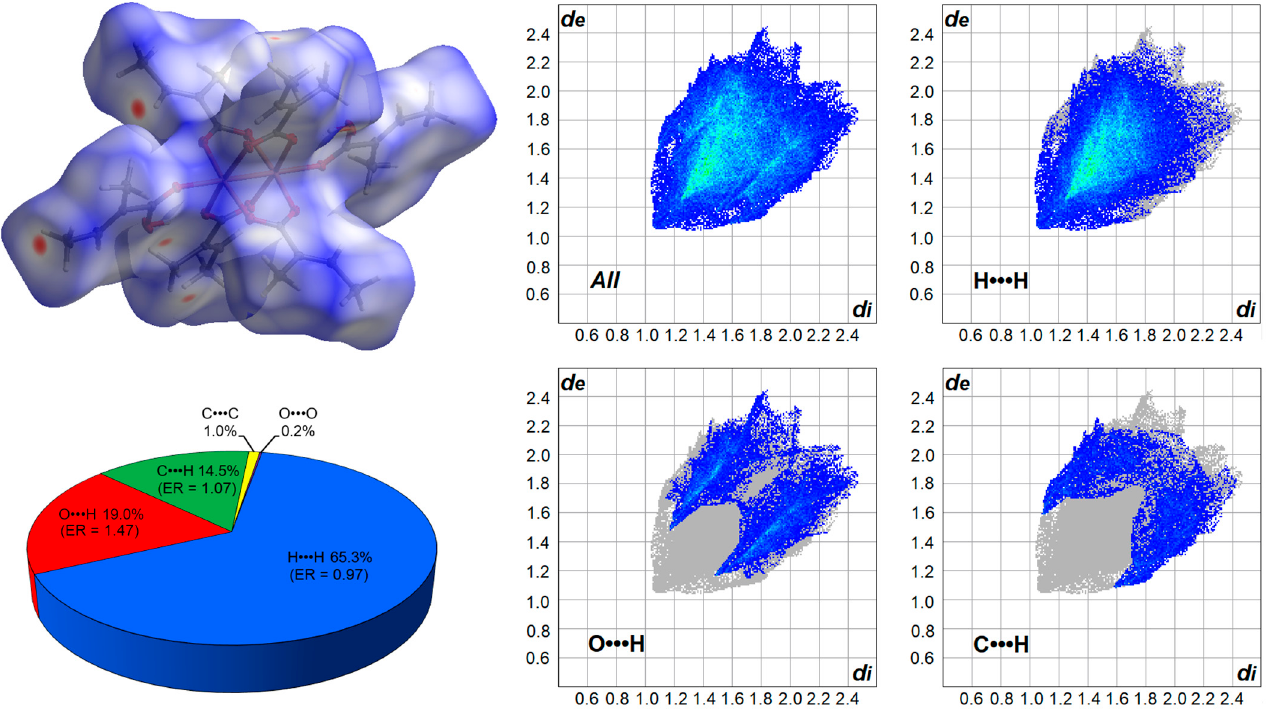
Figure 4. Hirshfeld surface (plotted over d norm ), 2D fingerprint plots, and percentage distribution of the intermolecular contacts in the studied compound.